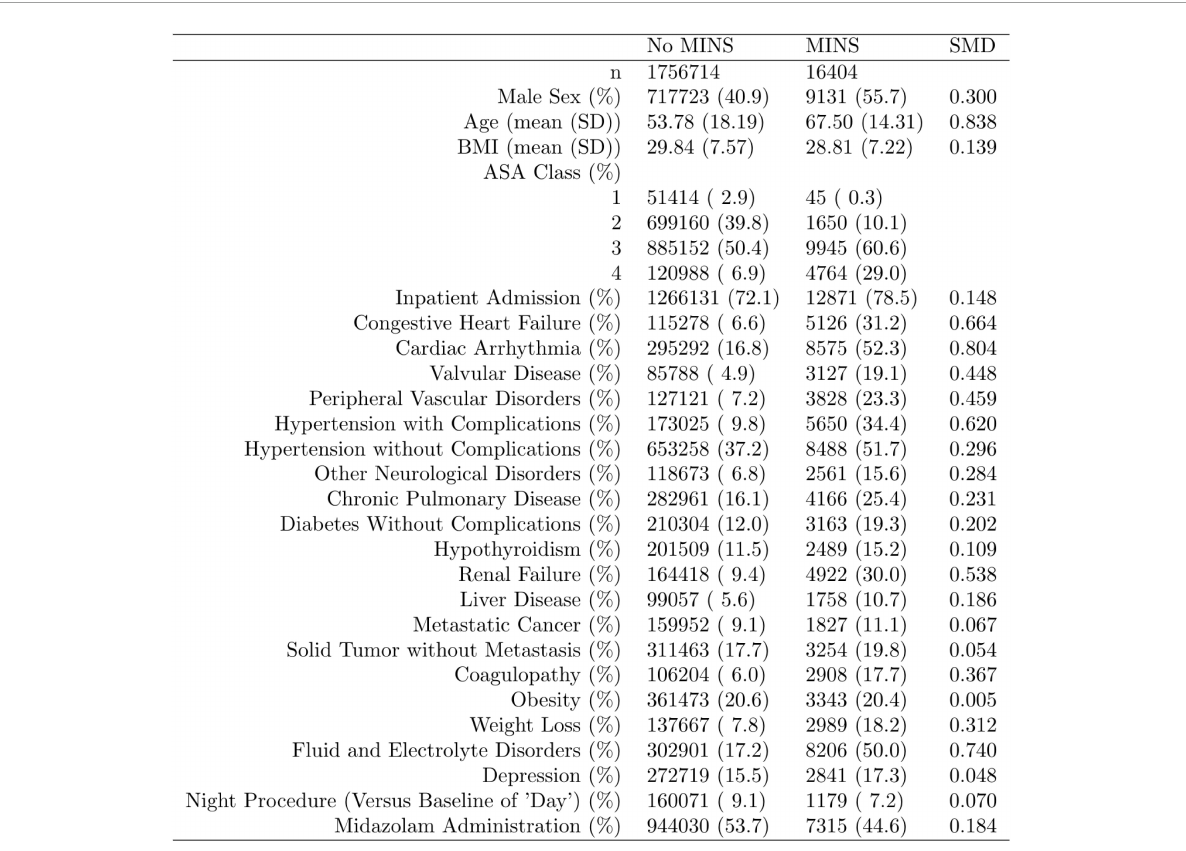
logistic regression framework via the R package survey (version 4.1-1), where weights are generated via propensity